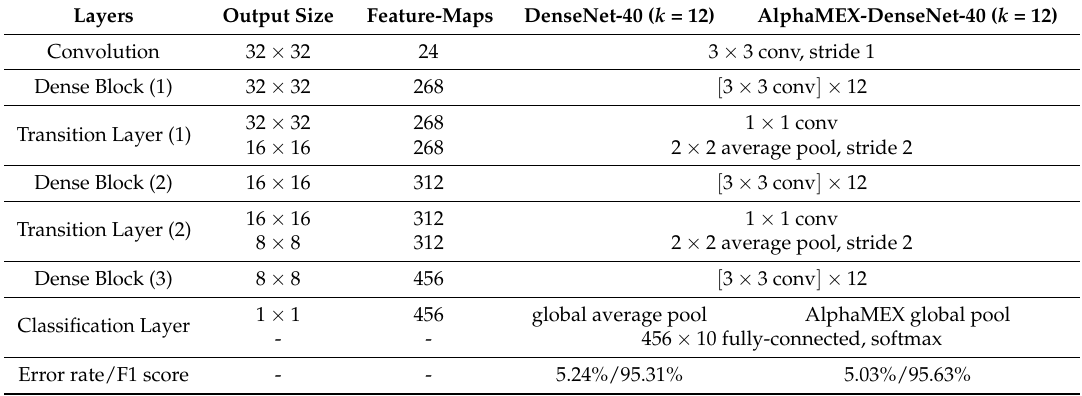
Table 1. DenseNet40 and AlphaMEX-DenseNet40 architectures for CIFAR. Error rate is calculated on CIFAR-10 dataset with standard data